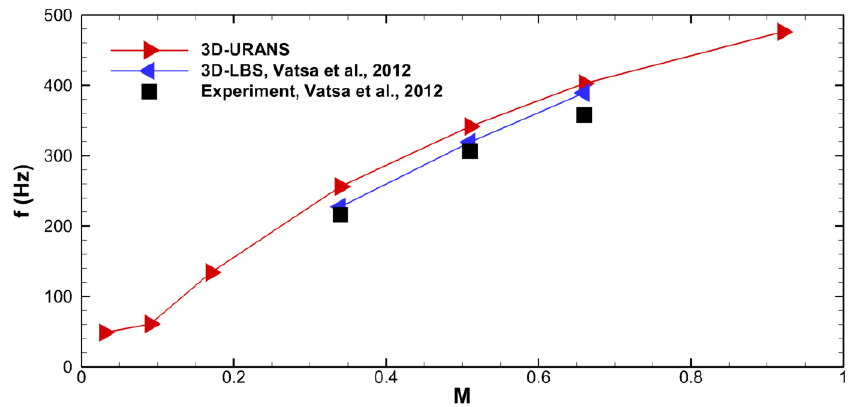
Figure 14. Jet oscillation frequency for increasing Mach number and comparison with results of Vatsa Vatsa et al. [53]. et al. [53].